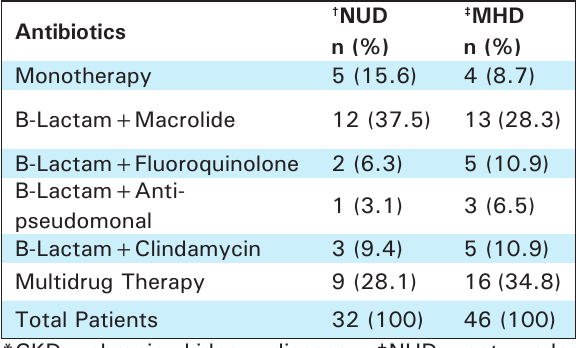
Table 3. Antibiotic use based on *CKD